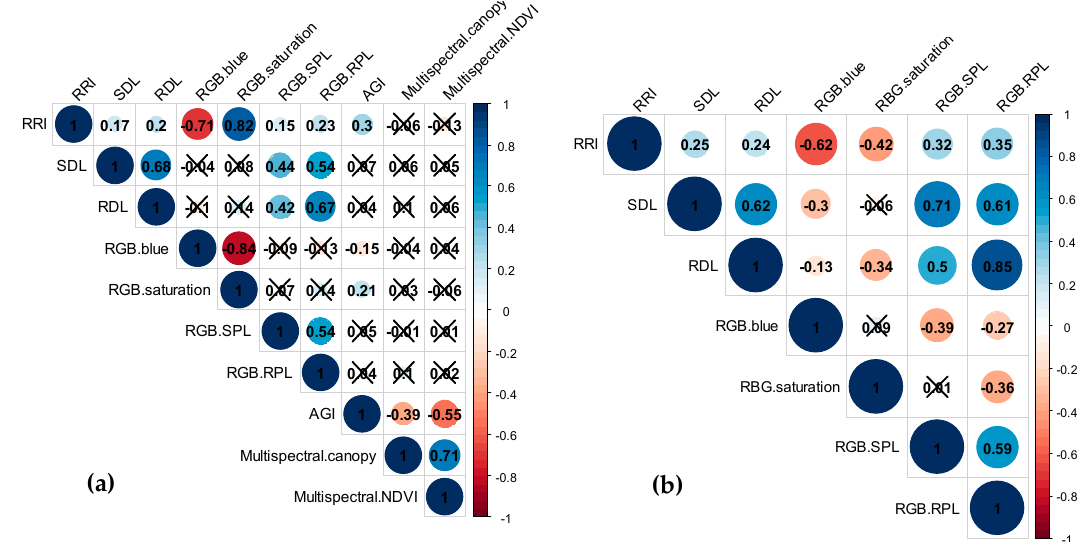
Figure 1. Heatmaps of correlation coe ffi cients between the ARR resistance traits in ( a ) the RIL population and ( b ) the association mapping population. Blue color represents positive correlation and red color indicates negative correlation. Cross mark shows there is no significant correlation observed between the given traits ( p > 0.05).